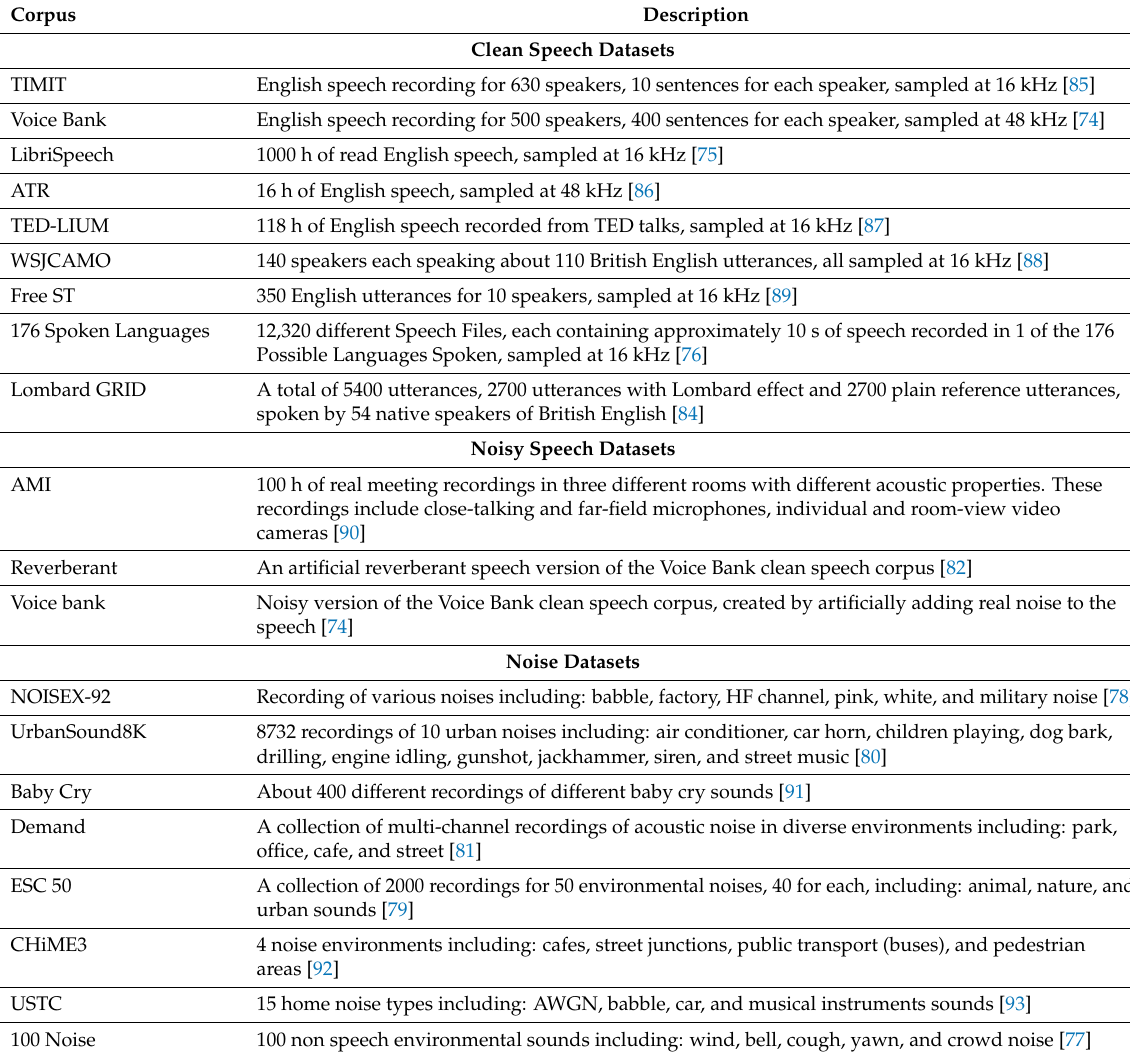
Table 2. A review of the available speech, noisy, and noise